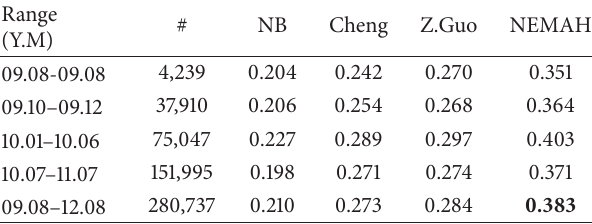
Table 2: Recommendation Micro-F1 (Top@30) of different time periods for different classification based systems.